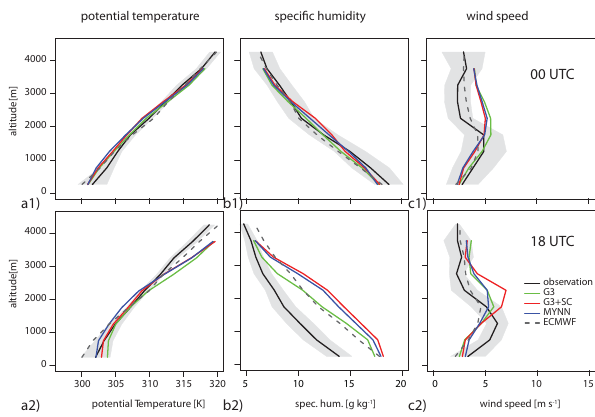
Fig. 3. Comparison of the meteorological variables potential tem- perature, specific humidity, and wind speed from different WRF meteorologies (green – G3, red – G3+SC, blue – MYNN) and from ECMWF (grey dashed) with radiosonde profiles for Manaus, averaged for the period of 18–29 November 2008 during BARCA- A at 00:00UTC (upper panel) and 18:00UTC (lower panel). The grey shaded area indicates the 1-sigma standard deviation of the ra- diosonde